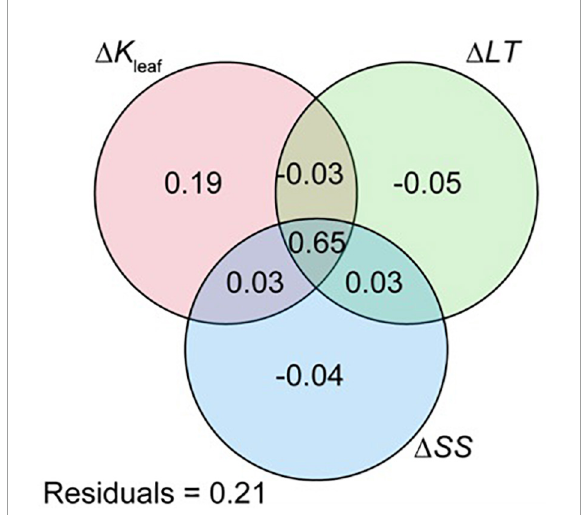
FIGURE5 Venn diagram showing the results of variance partitioning on a full model of (cid:49) A n with (cid:49) K leaf , (cid:49) LT , and (cid:49) SS (including (cid:49) SA and (cid:49) SD ) as explanatory variables. Results are shown as a percentage of explained variance. A n , K leaf , LT , S A , and SD indicate photosynthetic rate, leaf hydraulic conductivity, leaf thickness, stomatal area, and stomatal density,